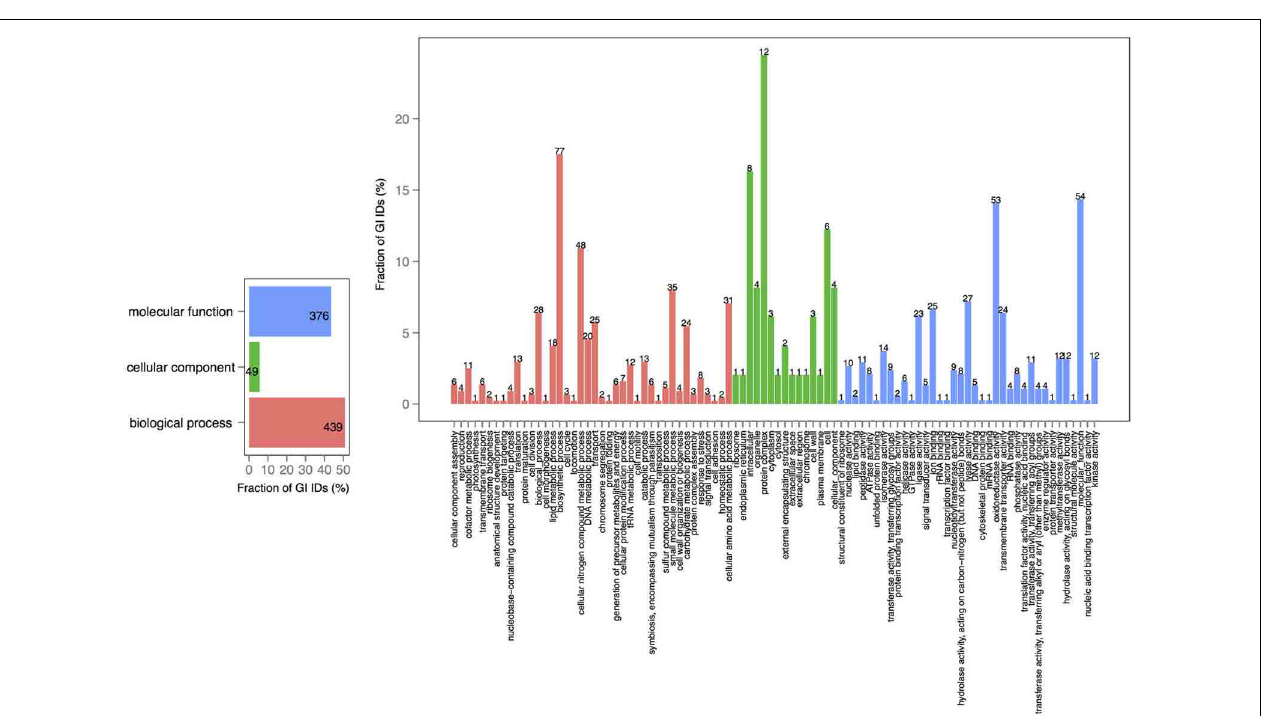
FIGURE 8 | GO term analysis in proteins, specific to V. cholerae draft genomes. Distribution is shared both as the percentage on the axis and the absolute number above the bar. The absolute number shows the amount of